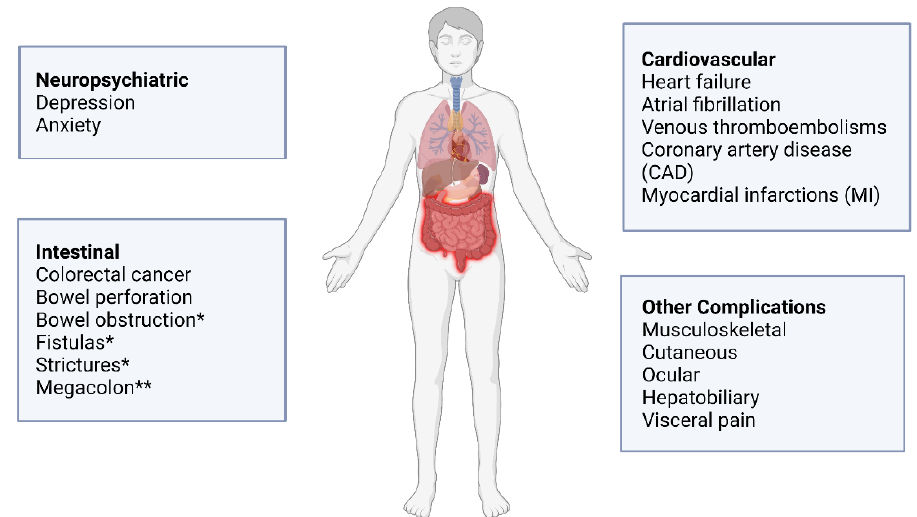
Figure 1. Intestinal and extraintestinal complications of IBD. * Mainly associated with Crohn’s disease; ** mainly associated with ulcerative colitis. Created with Biorender.com.